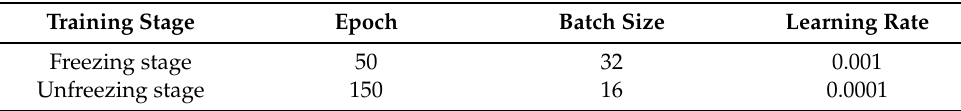
Table 1. The parameters at different stages of